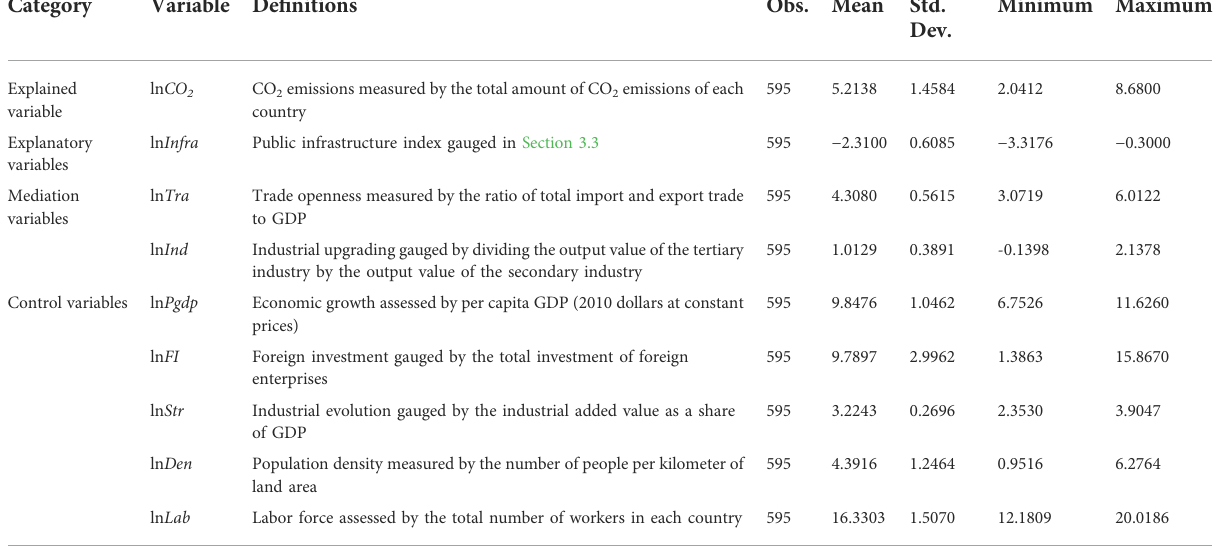
TABLE 1 De fi nitions and descriptive statistics of the variables used.